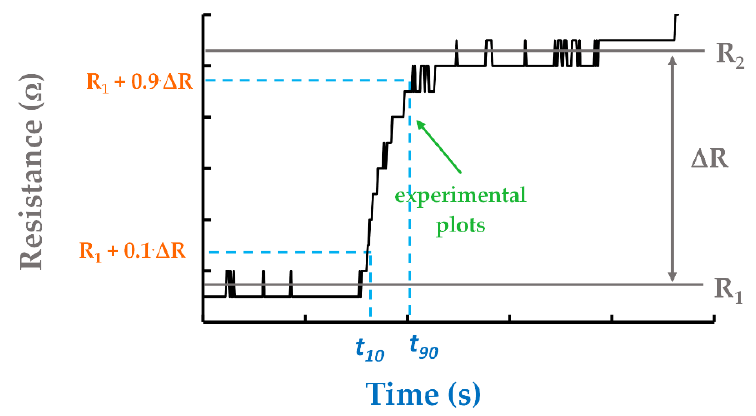
Figure 9. Calculation of response time between two steps of relative humidity. The response time varied from 35 to 100 s for both sensors when relative humidity was changed in the testing chamber (Figure 10). The highest values of response time were registered when the relative humidity exceeded 70%. A longer response time corresponding to the high level of RH can be explained by decreasing the number of active sites.